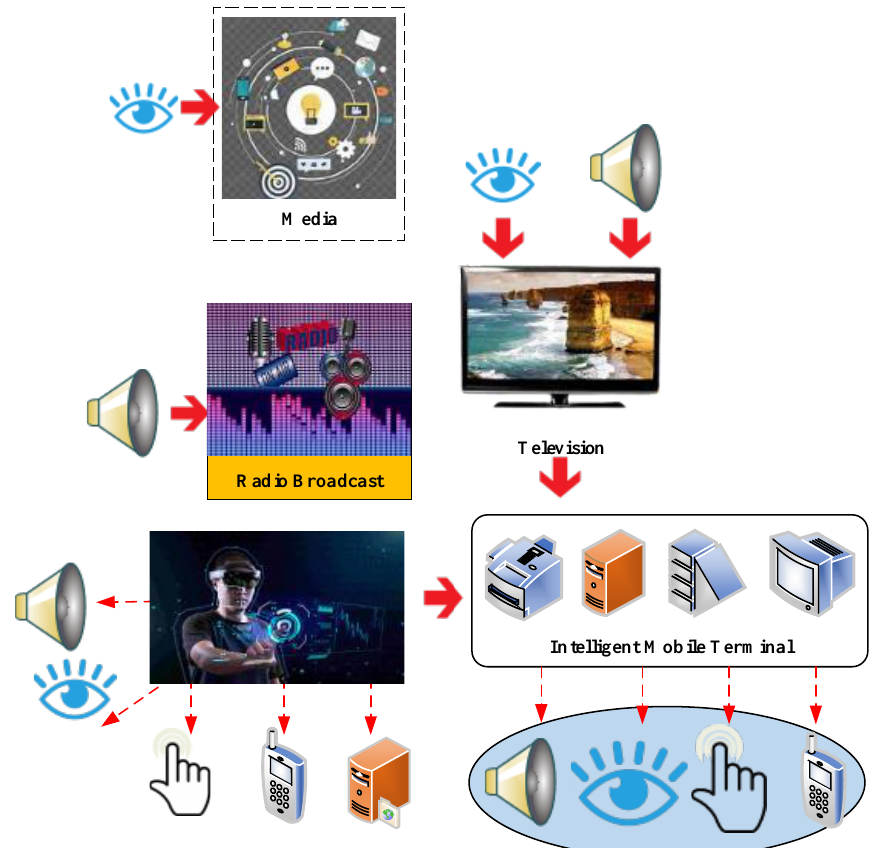
Figure 1. The history of HCI.